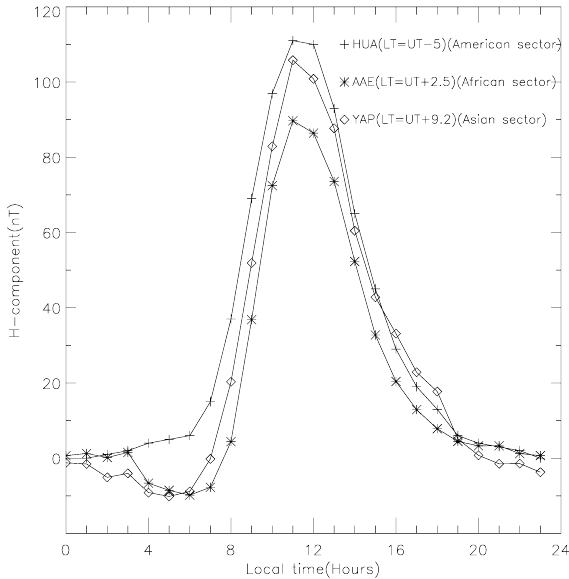
Fig. 7. Results for the year 1998: Diurnal variations of the DP2 enhancement ration average in 1998 at dip-equator compared to low latitude over the American (HUA), African (AAE) and Asian(YAP) sectors.